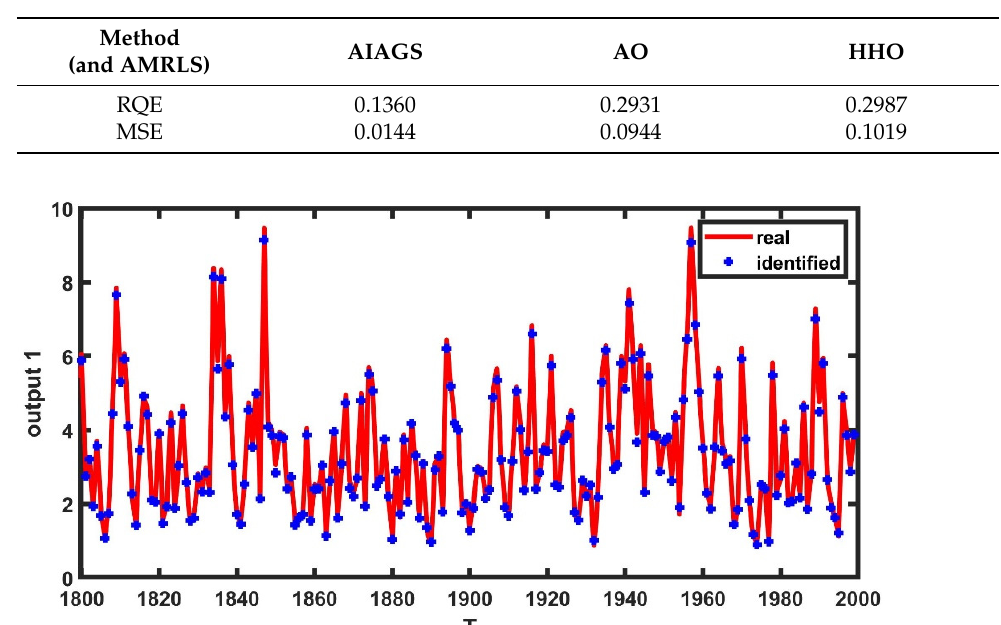
Table 5. The RQE and MSE of the results.